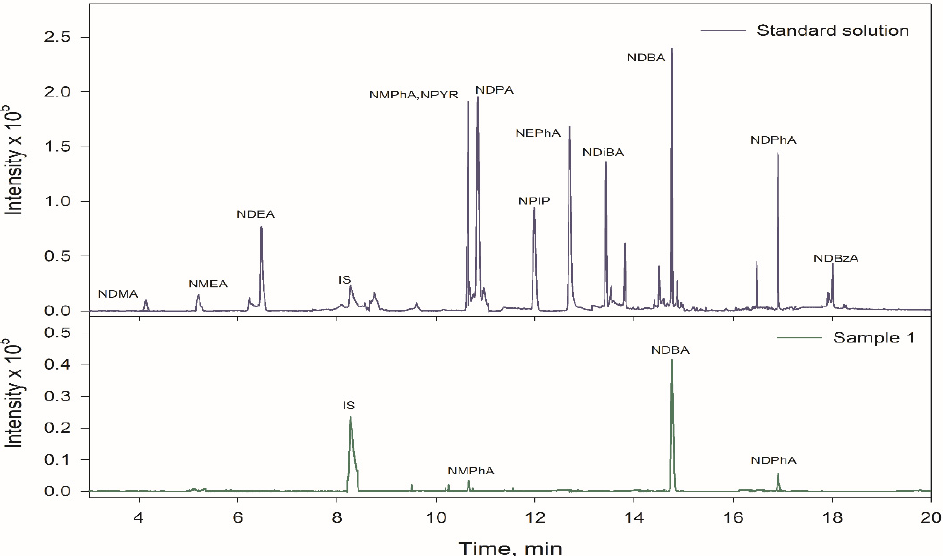
Figure 2. Chromatograms obtained for a standard solution mixture at 50 ng g − 1 for all the compounds and unfortified sample 1 using the optimized method.